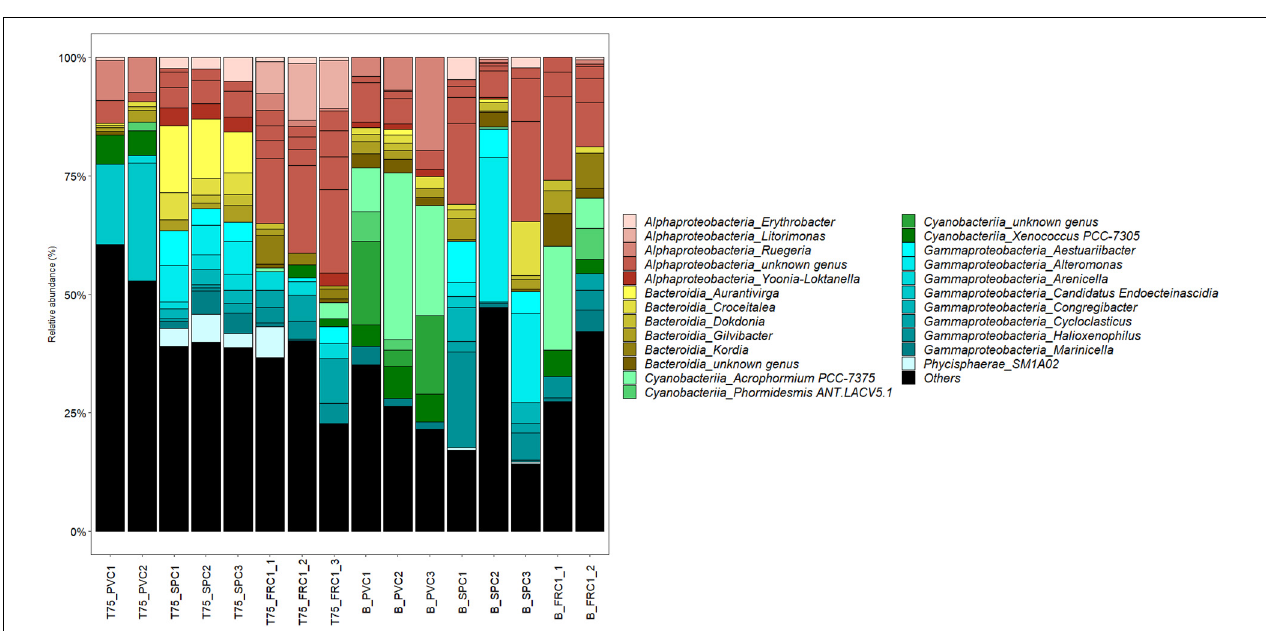
FIGURE 6 | Relative abundance at the genus level after 75 days of immersion at Toulon and Banyuls on the different surfaces (triplicates except PVC at Toulon and FRC1 at Banyuls that displayed only duplicates). Others were genera representing less than 0.5% of the reads.